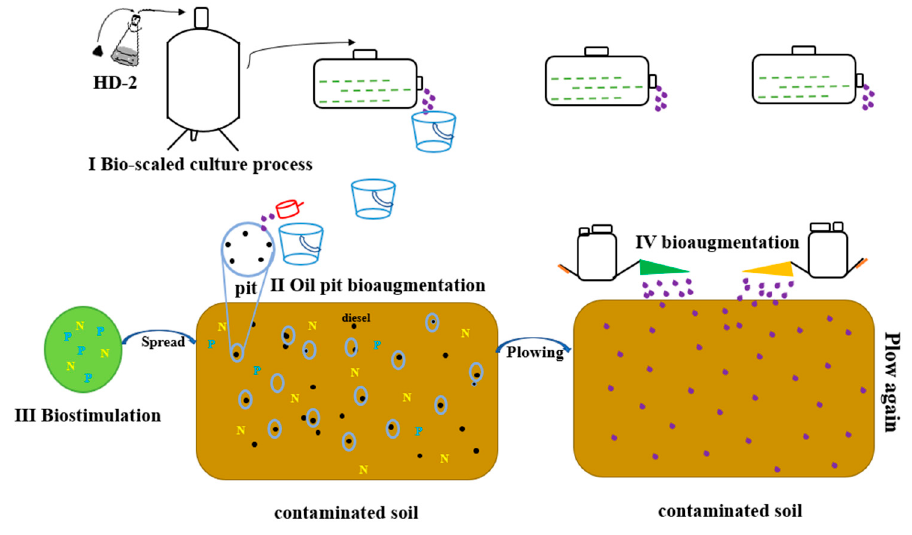
Figure 8. Flow chart of biostimulation-bioaugmentation joint remediation process to deal with diesel-contaminated soil.